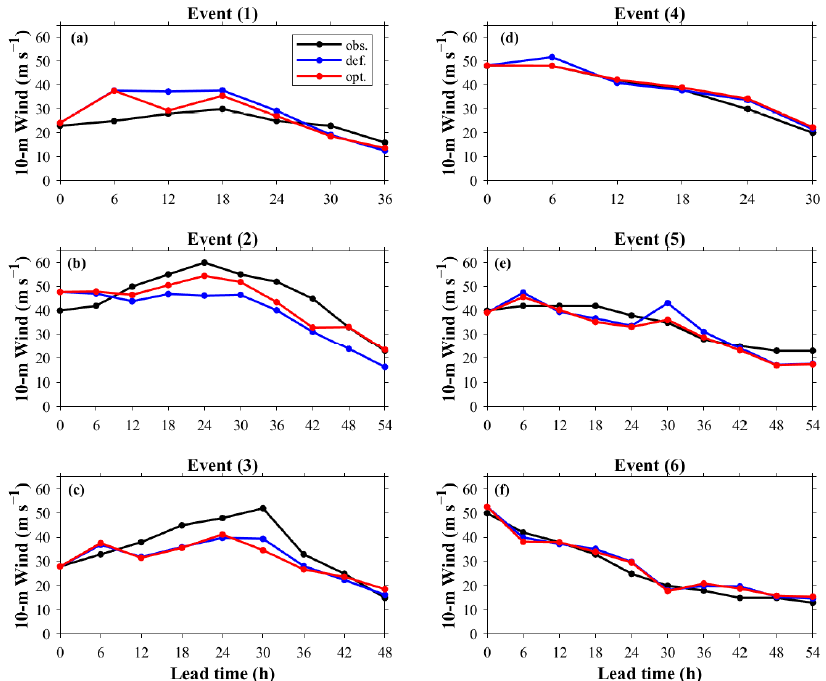
Figure 8. Comparisons of 10-m wind evolution simulations for six optimized events. ( a ) − ( f ) represent the typhoon events (1) − (6) respectively.